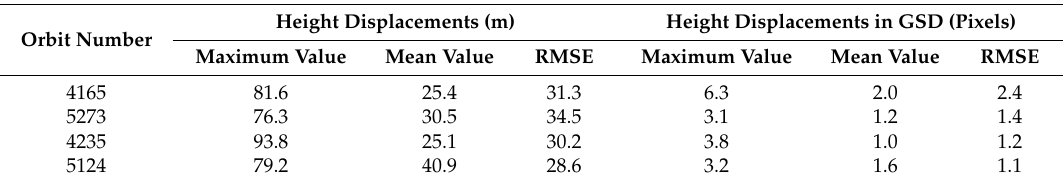
Table 6. The height displacements between the generated DEM and the HRSC Level-4 DEM. RMSE: root mean square errors; GSD: ground sample